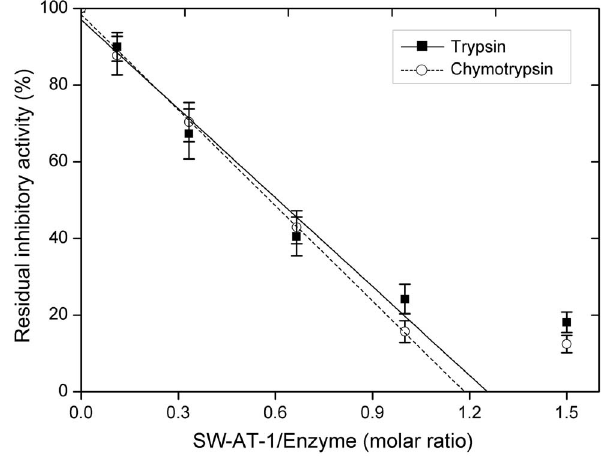
Figure 3. Stoichiometry of inhibition. Trypsin and chymotrypsin were incubated respectively with different concentrations of SW-AT- 1 at 25 u C for 20 min in the appropriate reaction buffer. Residual enzyme activity was measured by adding the appropriate substrate and determining the reaction velocity. The stoichiometry of inhibition was determined by using linear regression to extrapolate to that initial inhibitor/enzyme ratio resulting in complete inhibition of the enzyme. doi:10.1371/journal.pone.0099013.g003 PLOS ONE |